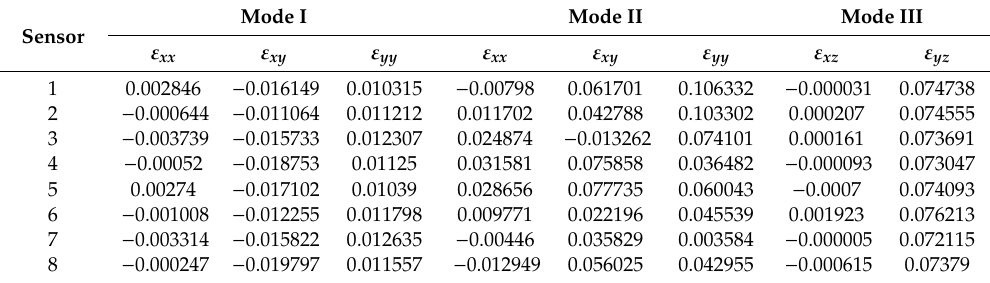
Table 4. Calculated strains (unit µ ) of the eight sensors in composite plate with a crack (BEM). Sensor